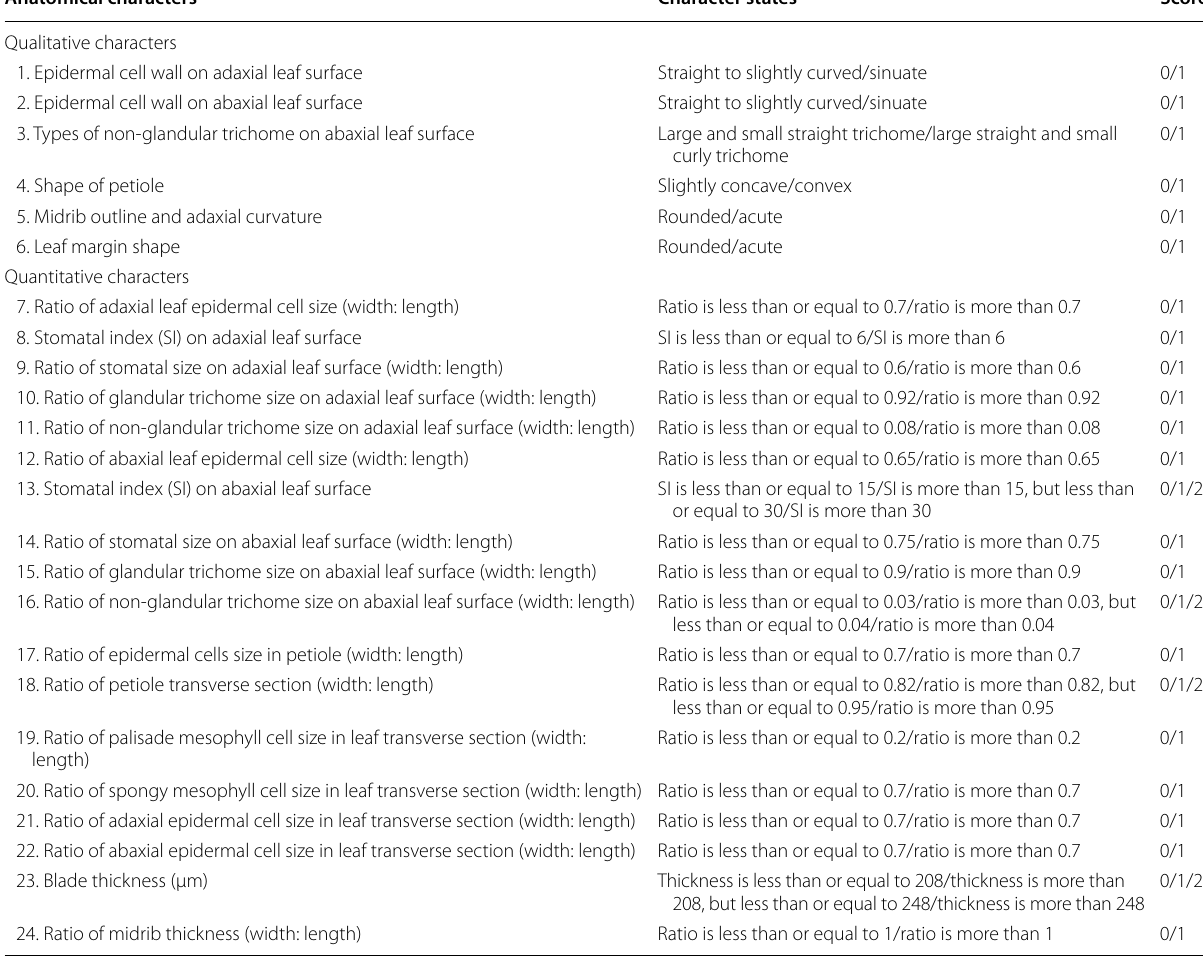
Table 2 The leaf anatomical characters and character states used in phenetic